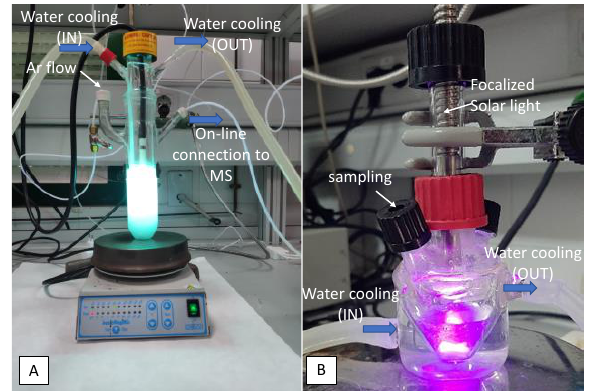
Figure 2. Picture of the photocatalytic reactors used in the hydrogen production from glycerol photo-reforming. ( A ) UV-light. ( B ) Solar light.